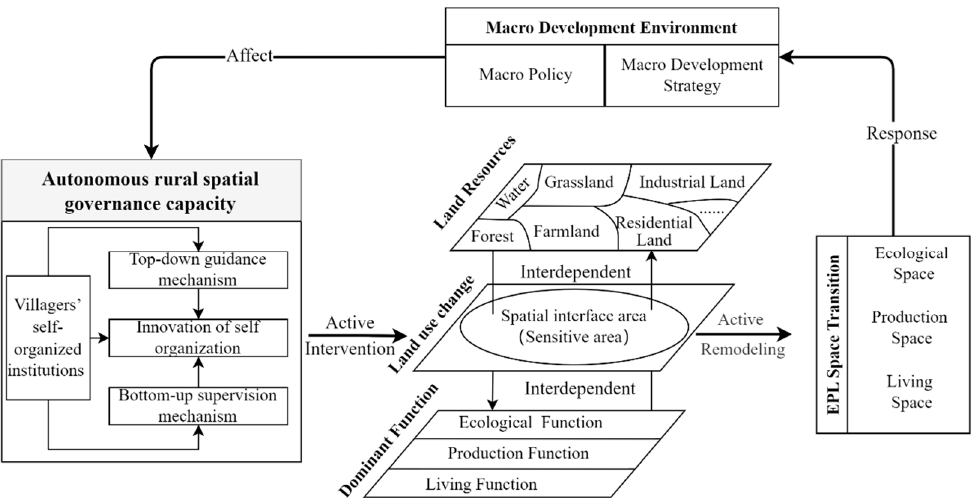
Figure 9. Driving mode of EPL spatial land use transformation.